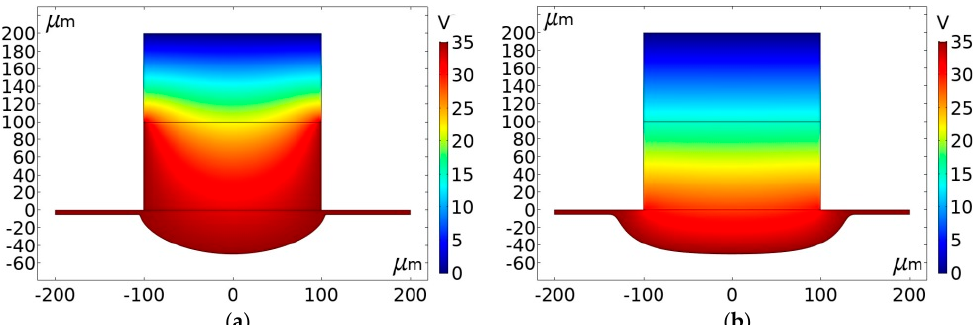
Figure 4. Simulation results using different masks. ( a ) Using the conductive mask; ( b ) Using the insulated mask.